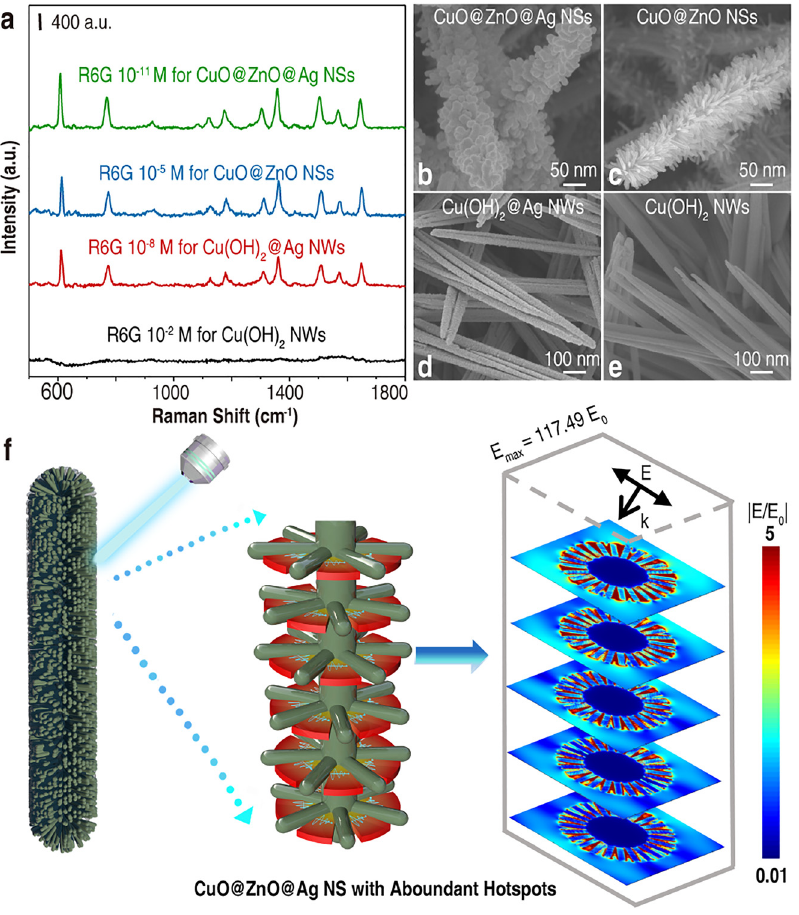
Figure 2: (a) Raman spectra of R6G collected from CuO@ZnO@Ag NSs, CuO@ZnO NSs, Cu(OH) 2 @Ag NWs and Cu(OH) 2 NWs, respectively; SEM images of (b) CuO@ZnO@Ag NSs, (c) CuO@ZnO NSs, (d) Cu(OH) 2 @Ag NWs and (e) Cu(OH) 2 NWs, respectively; and (f) simulated EFDs in CuO@ZnO@Ag NS at different positions along the lengthwise direction of the